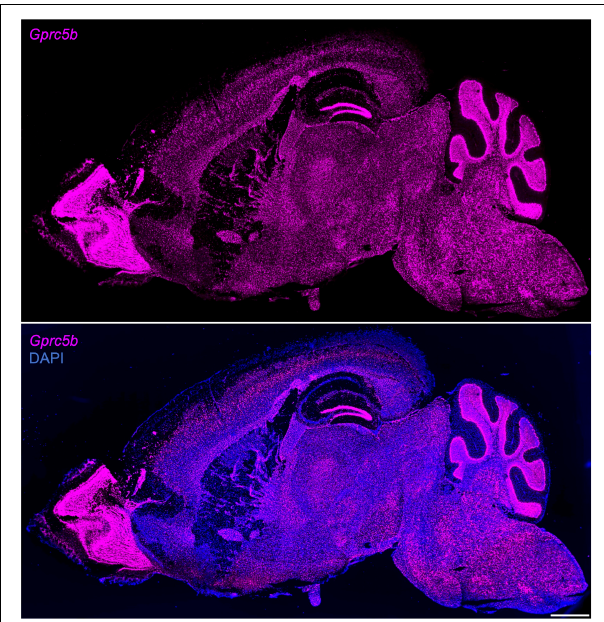
FIGURE 3 | Sagittal overview of Gprc5b mRNA distribution throughout mouse brain. Sagittal sections of adult C57BL/6J mouse brain using RNAscope in situ hybridization (10 × , stitched) hybridized with Gprc5b probe (top panel) and merged image of the section counterstained with DAPI (bottom panel) . Scale bar: 1 mm.